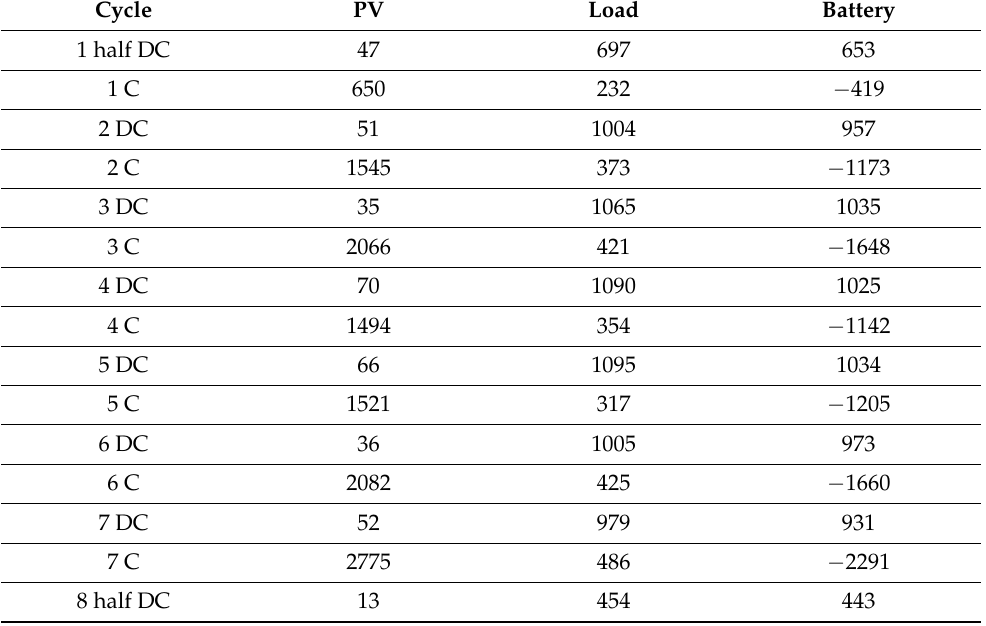
Table 2. Daily energy variations for PV, load and battery in Wh with an energy scaling factor, S E , of 1 / 4 (C-charge,